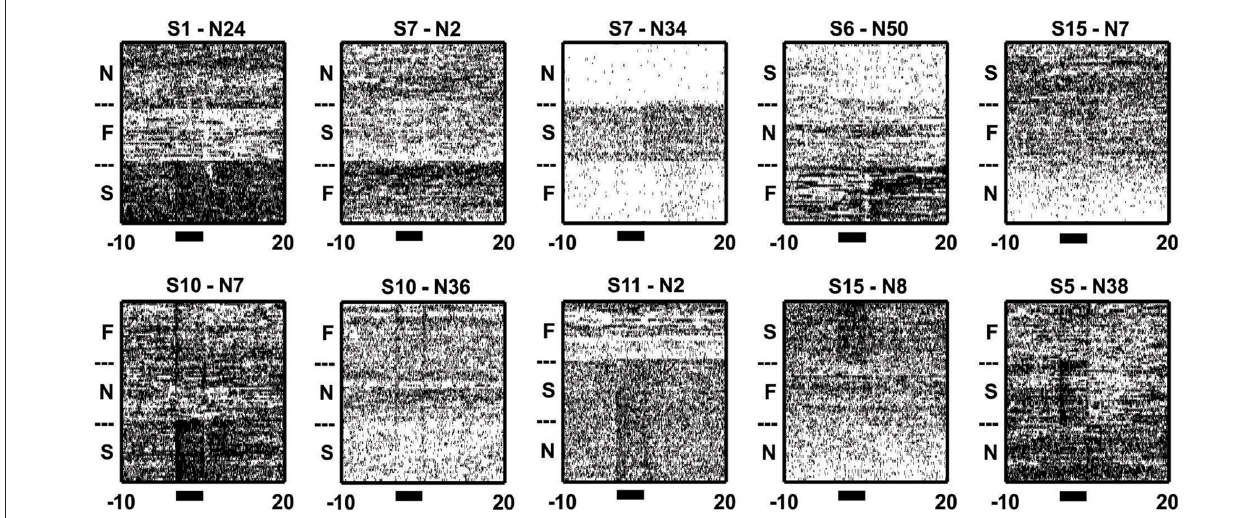
FIGURE 5 | Inter-trial/background activity differed across blocks. Sample raster plots from 10 neurons illustrating the changes in activity during trial and inter-trial periods of different blocks. Note how the neurons changed their firing throughout both the trial (black bars) and/or inter-trial periods of the blocks. The subheadings give the session and neuron numbers, while the N, F and S denotes N-block, F-block and S-block,